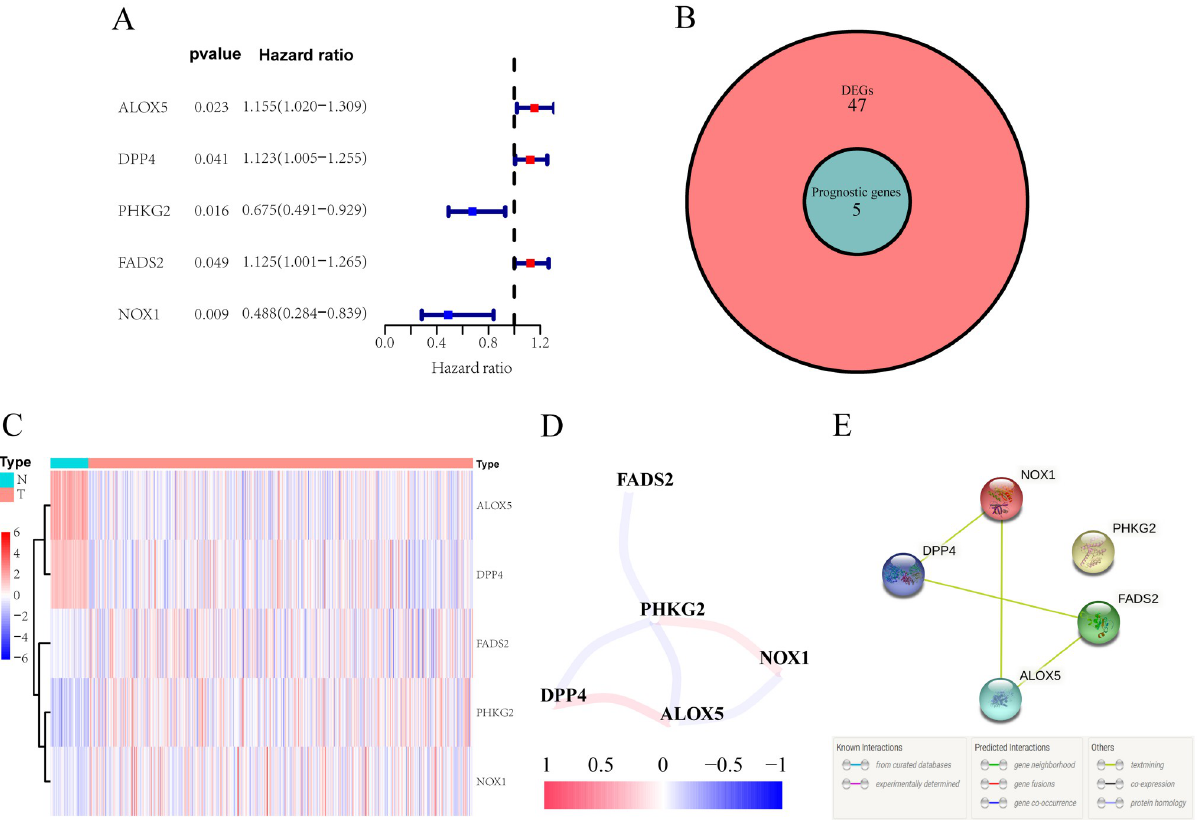
Fig 1. Identification of the candidate ferroptosis-associated genes in the TCGA cohort. A. Forest plots showing the results of the univariate Cox regression analysis between gene expression and OS. B. Venn diagram to identify differentially expressed genes between tumor and adjacent normal tissue intersect with OS-correlated genes. C. The 5 overlapping genes were all difference expression between normal and tumor tissue. D. The correlation network of candidate genes. The correlation coefficients are represented by different colors (positive correlation is red, negative correlation is blue). E. The PPI network downloaded from the STRING database indicated the interactions among the candidate genes.